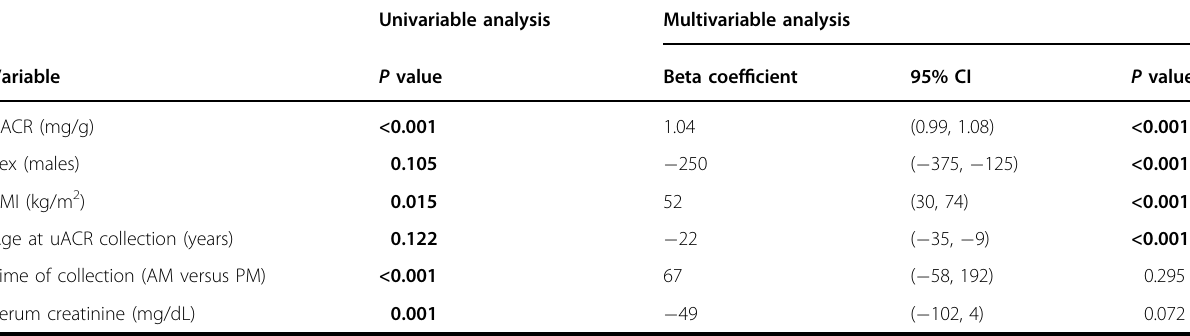
Table 4 Linear regression analysis